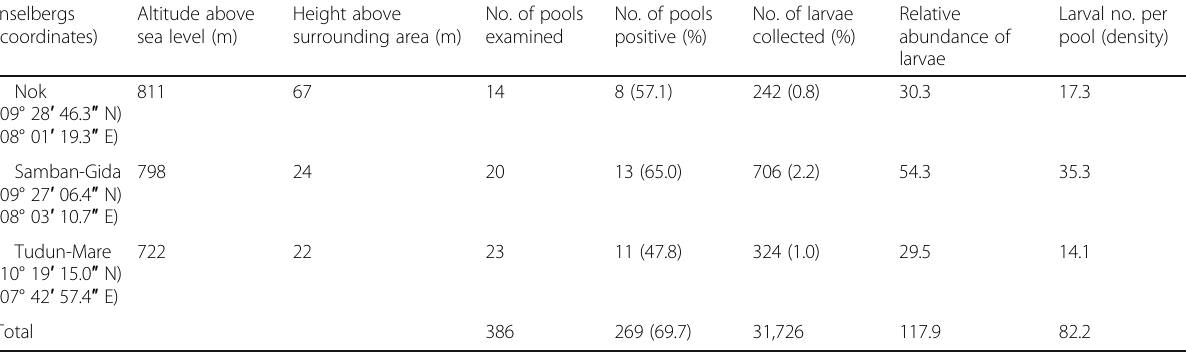
Table 1 Occurrence and abundance of mosquito larvae in rock pools on inselbergs in Kaduna State, Nigeria (Continued) Inselbergs Altitude above Height above No. of pools (coordinates) sea level (m) surrounding area (m)